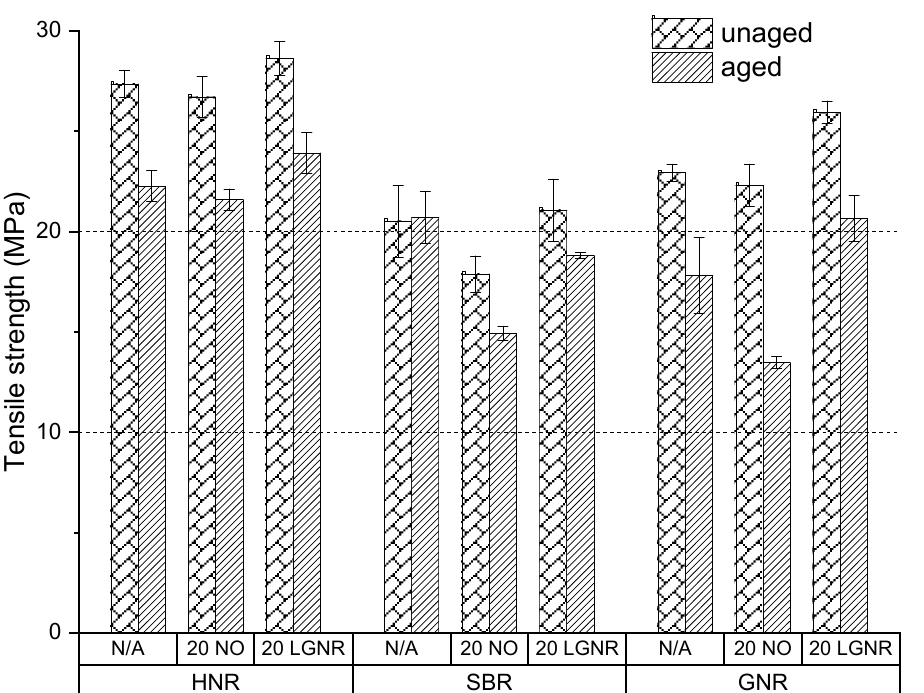
Figure 15. Aging effects on the tensile strength of HNR, SBR and GNR composites made with or without processing aids. N/A: rubber compounds without processing aids; 20 NO: rubber compounds with 20 phr naphthenic oil; 20 LGNR: rubber compounds with 20 phr liquid guayule natural rubber.